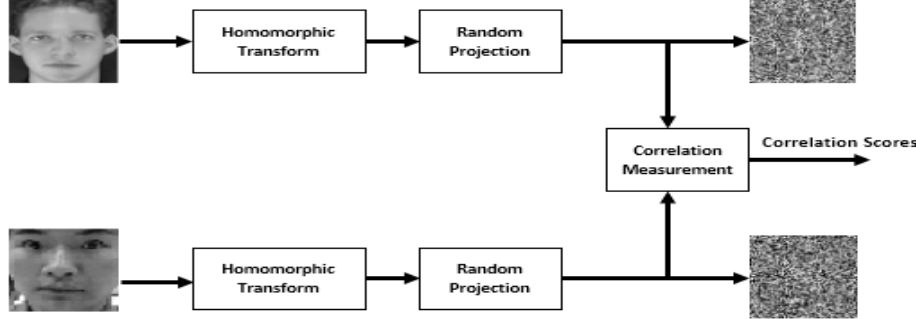
Figure 4. Proposed CFR framework based on homomorphic transform and RP (i.e., CFR2).